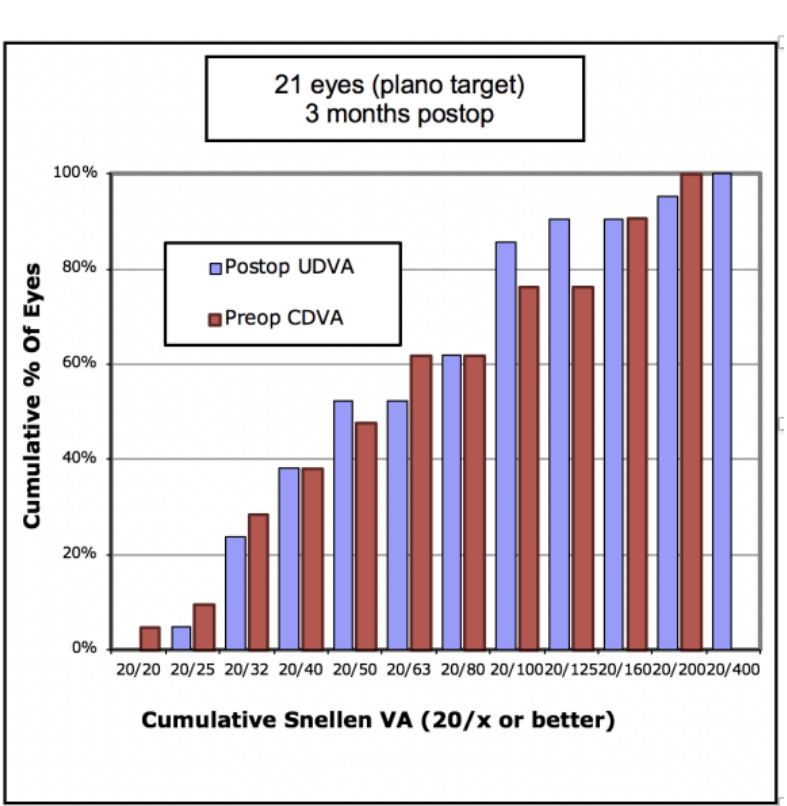
Figure 1. Cumulative pre-operative corrected distance visual acuity (CDVA) versus post-operative unaided distance visual acuity (UDVA) in 21 keratoconic eyes implanted with Ferrara intrastromal corneal ring segments.